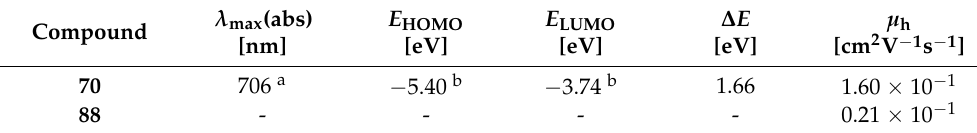
Figure 13. Thieno[2,3- b ]thiophene semiconducting derivatives 70 and 88 . Table 9. The optoelectronic properties overview of derivatives 70 and 88 applied in